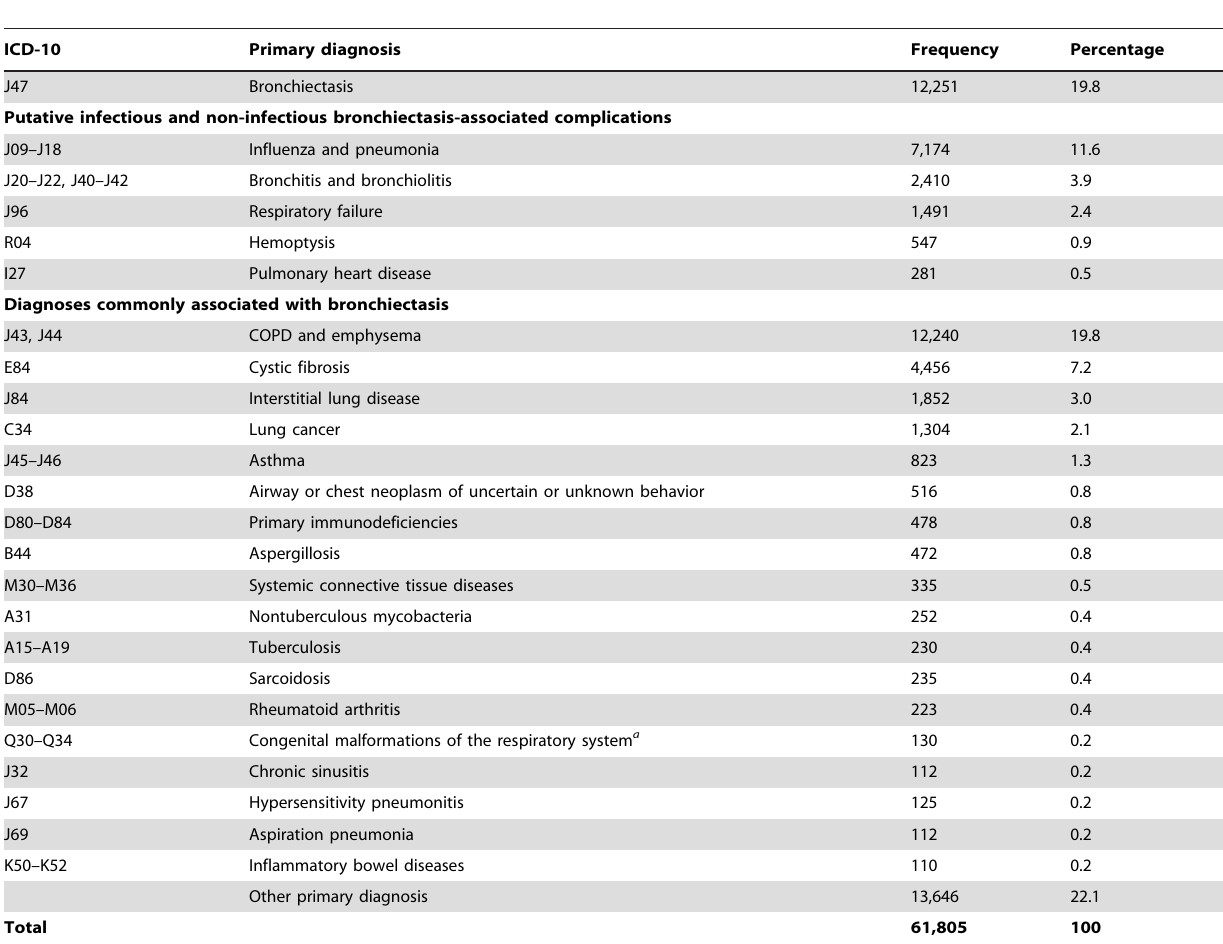
Table 4. Primary diagnoses among hospitalizations with bronchiectasis as any diagnosis, classified by putative infectious and non- infectious complications as well as diagnoses commonly associated with